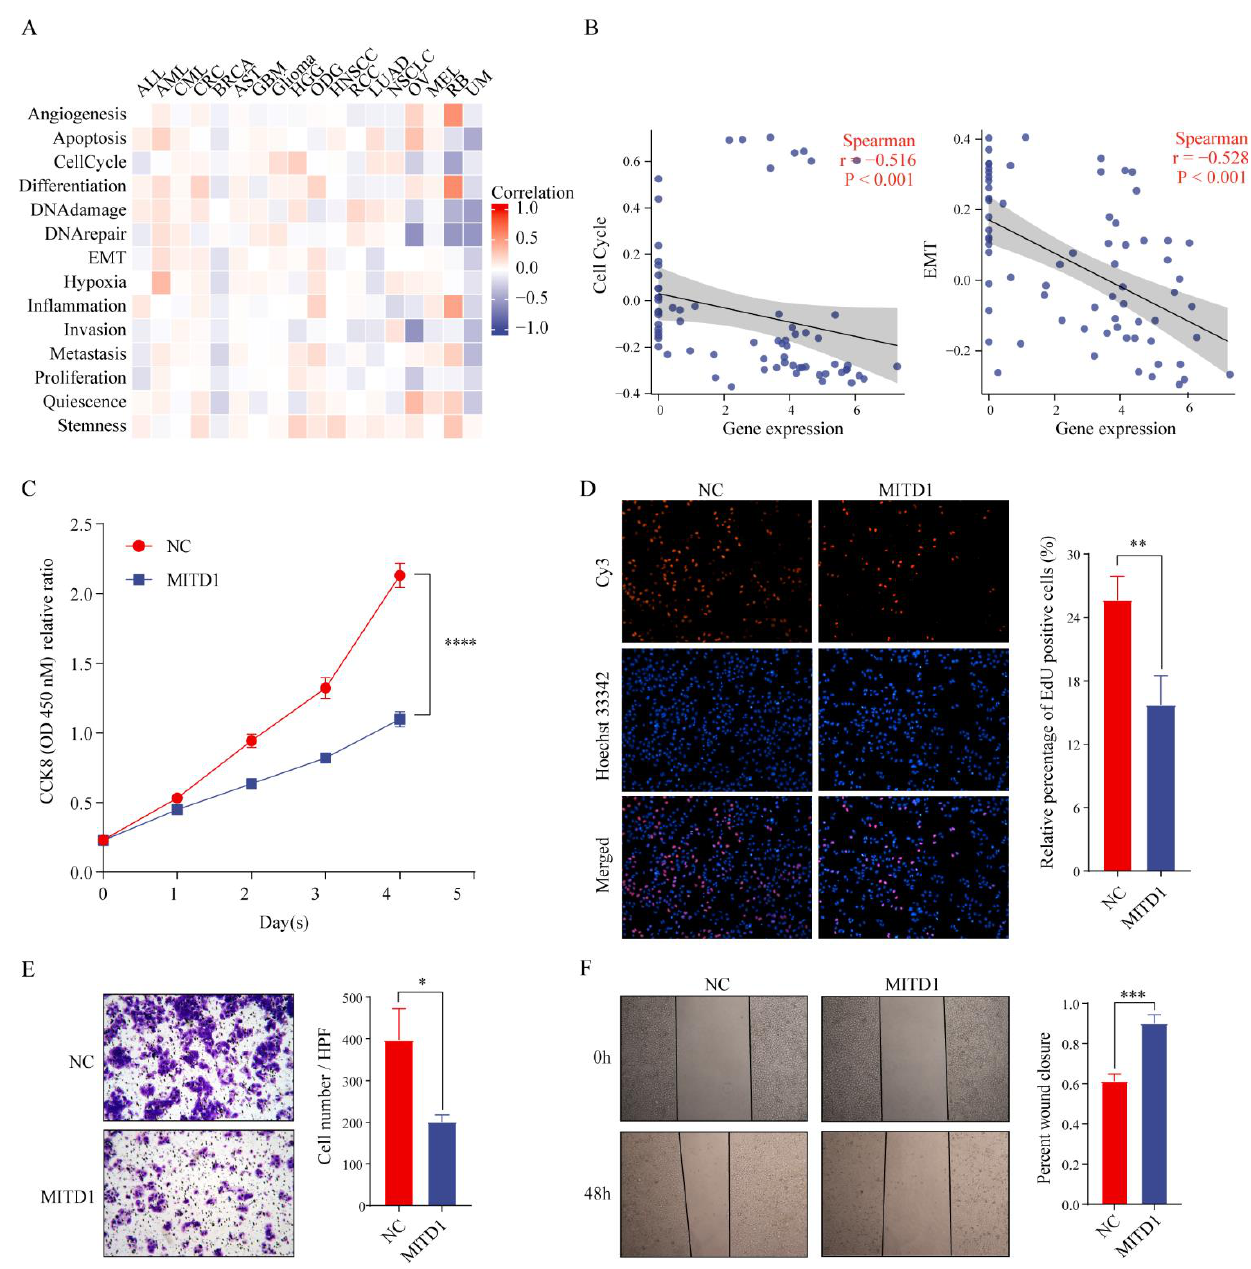
Figure 6. Functional analysis of MITD1. ( A ) Functional relevance of MITD1 at single-cell level through CancerSEA database. ( B ) The function analysis between MITD1 and cell cycle and epithelial– mesenchymal transition (EMT) at single-cell level. ( C ) CCK-8 analysis. ( D ) Representative images of EdU incorporation assay (magnification: × 100). ( E ) Representative images of Transwell analysis (magnification: × 100). ( F ) Representative images of wound healing analysis (magnification: × 40). * p < 0.05; ** p < 0.01; *** p < 0.001; **** p < 0.0001.